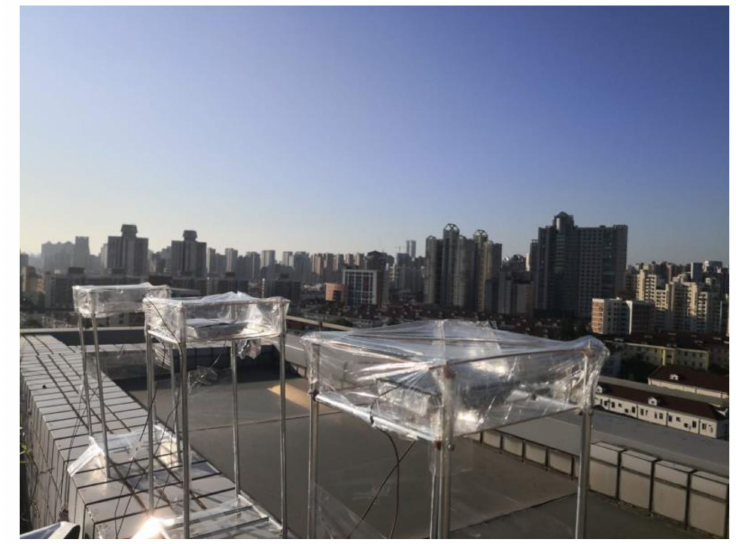
Figure A5. ( a ) Reflection spectrum of di ff erent points of the PAIP sample. ( b ) Absorption of four kinds of di ff erent materials.